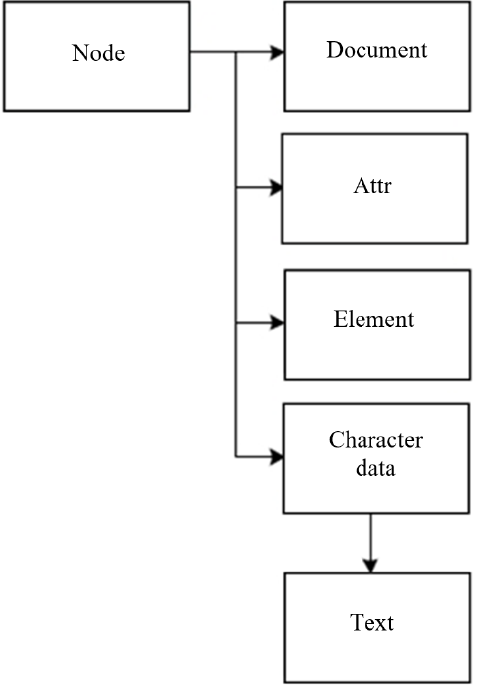
Figure 1. The structure of DOM inheritance [14].